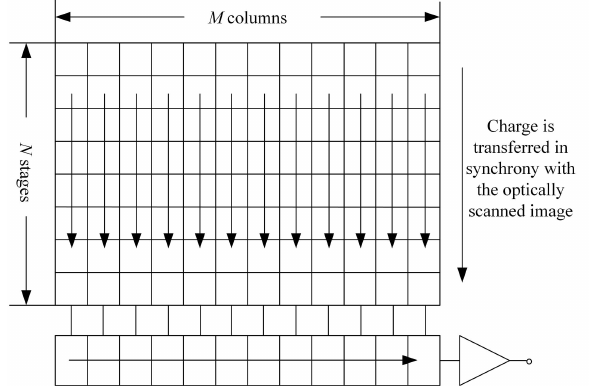
Figure 4. Schematic of TDI CCD (Wong et al.,